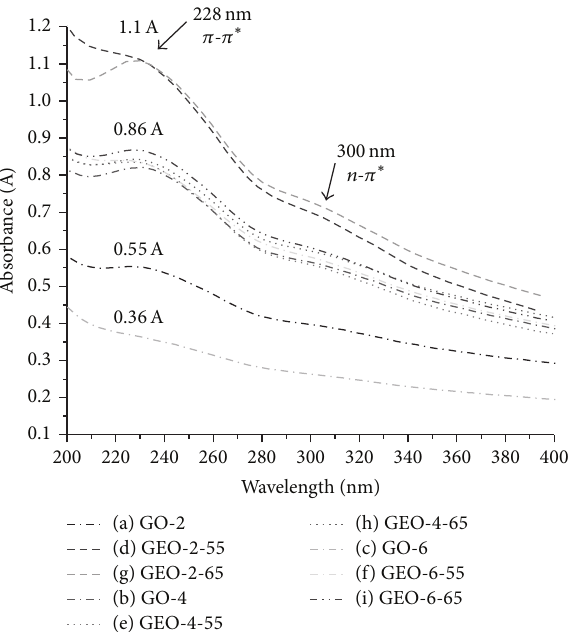
Figure4:UV-visspectraof(a)GO-2,(b)GO-4,(c)GO-6,(d)GEO- 2-55, (e) GEO-4-55, (f) GEO-6-55, (g) GEO-2-65, (h) GEO-4-65, and (i) GEO-6-65.